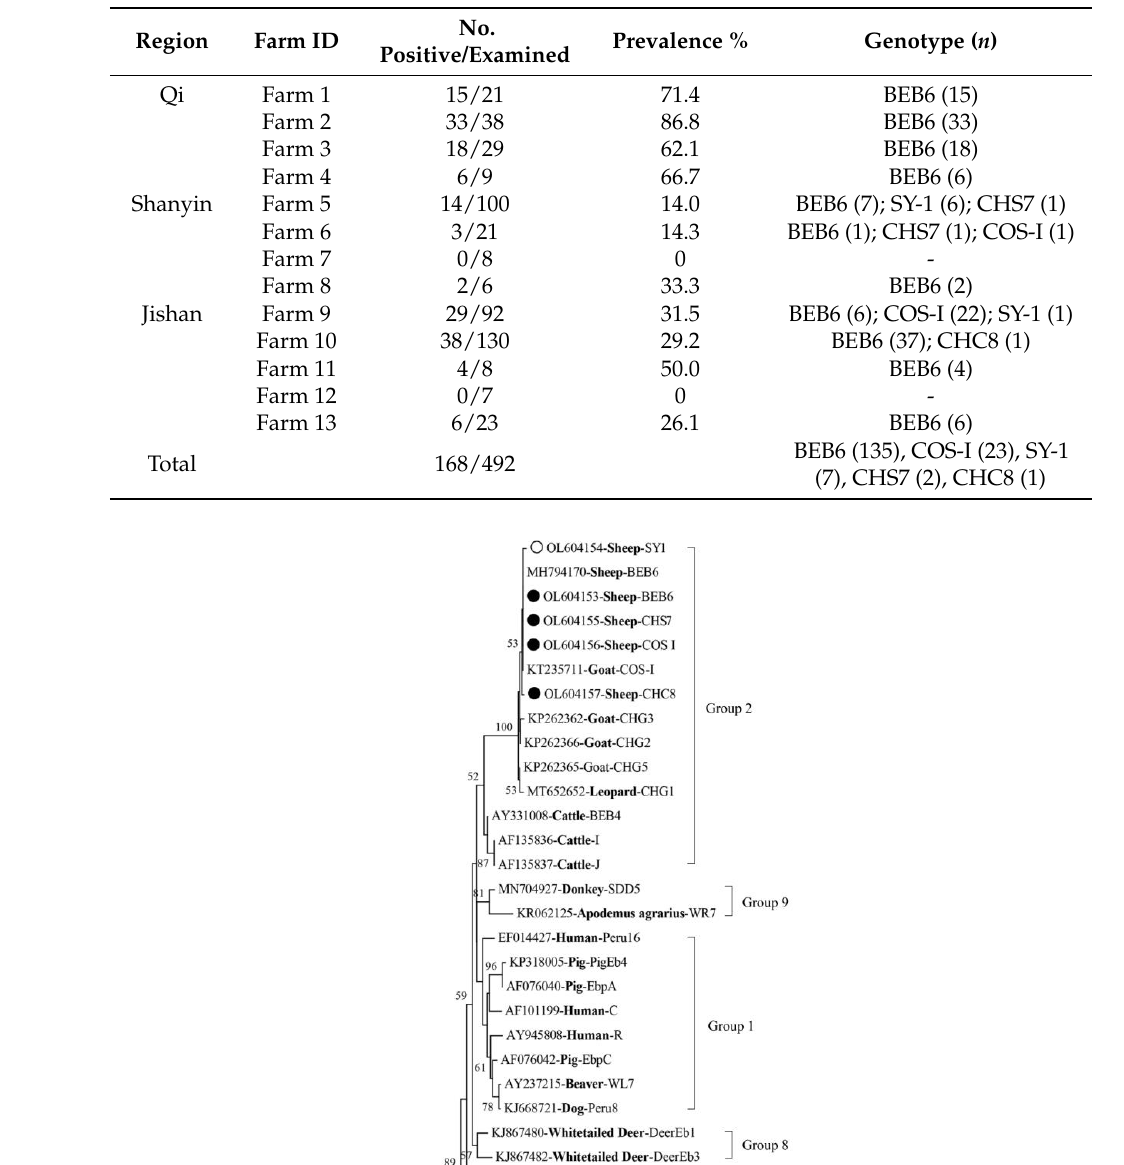
Table 2. Prevalence and genotypes of Enterocytozoon bieneusi in sheep in Shanxi Province.